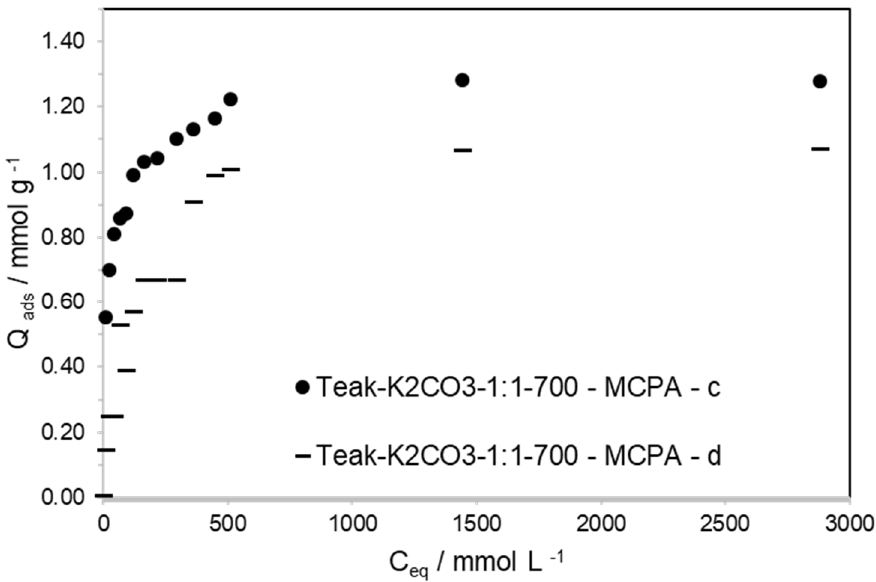
Figure 6. Kinetic study of adsorption of MCPA obtained from concentrated and dilute solutions.